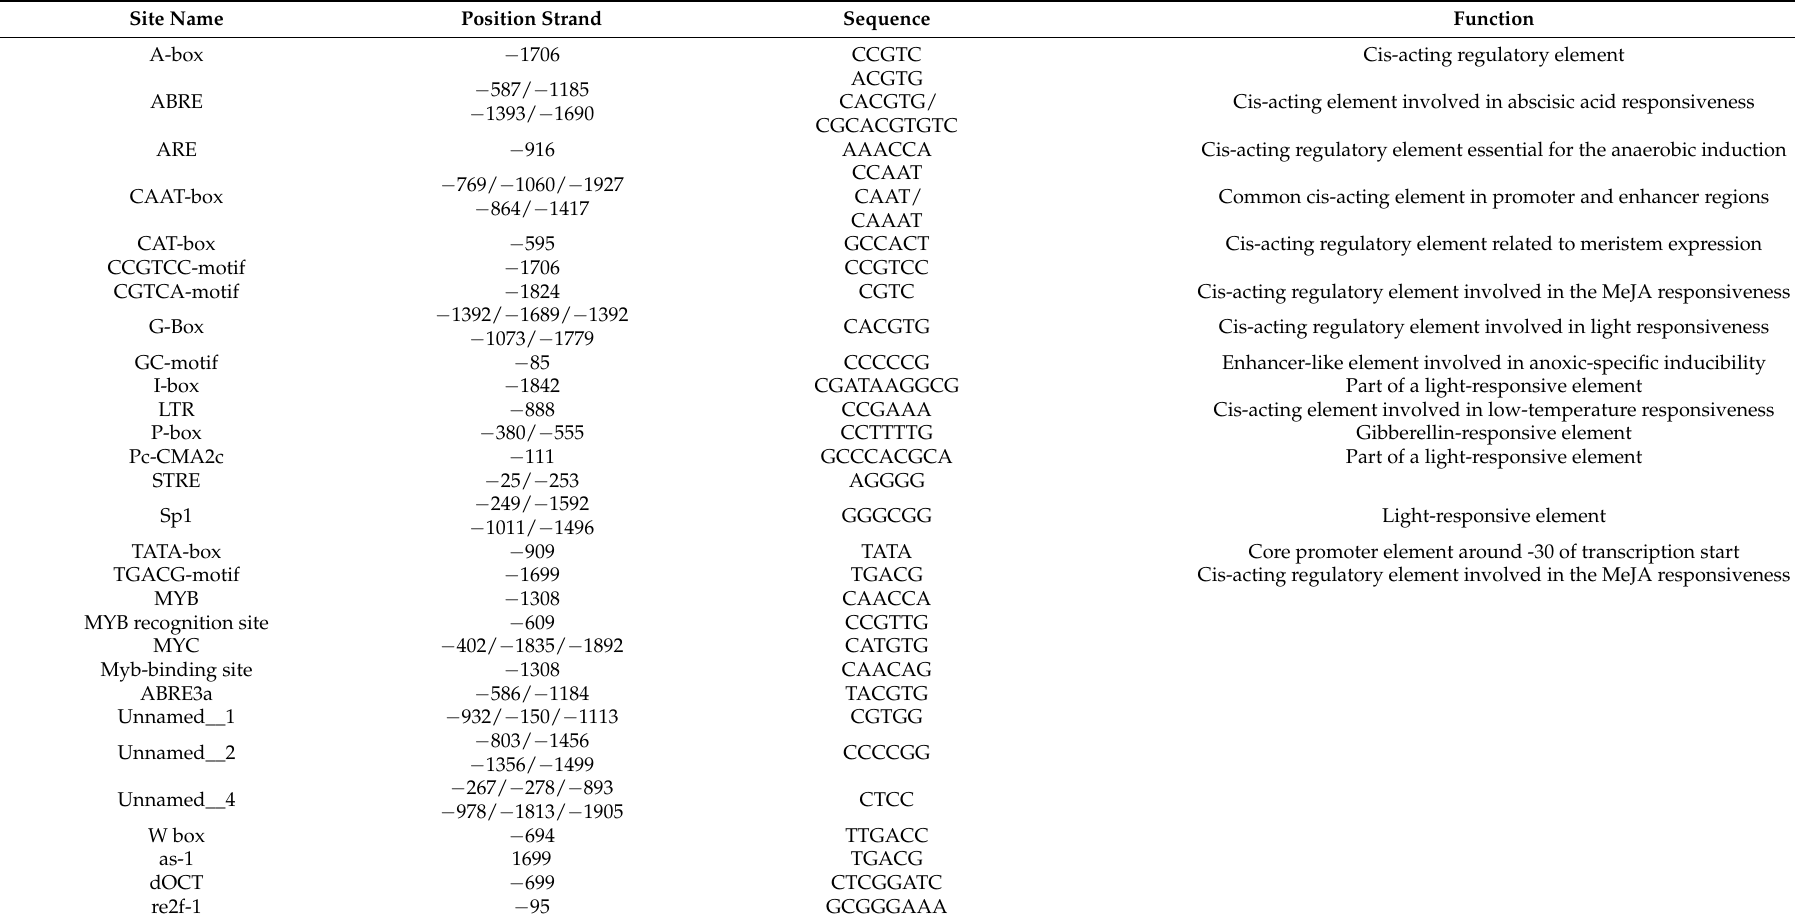
Table 1. Prediction of the cis-acting elements of the promoter region of the MrFPS gene in German